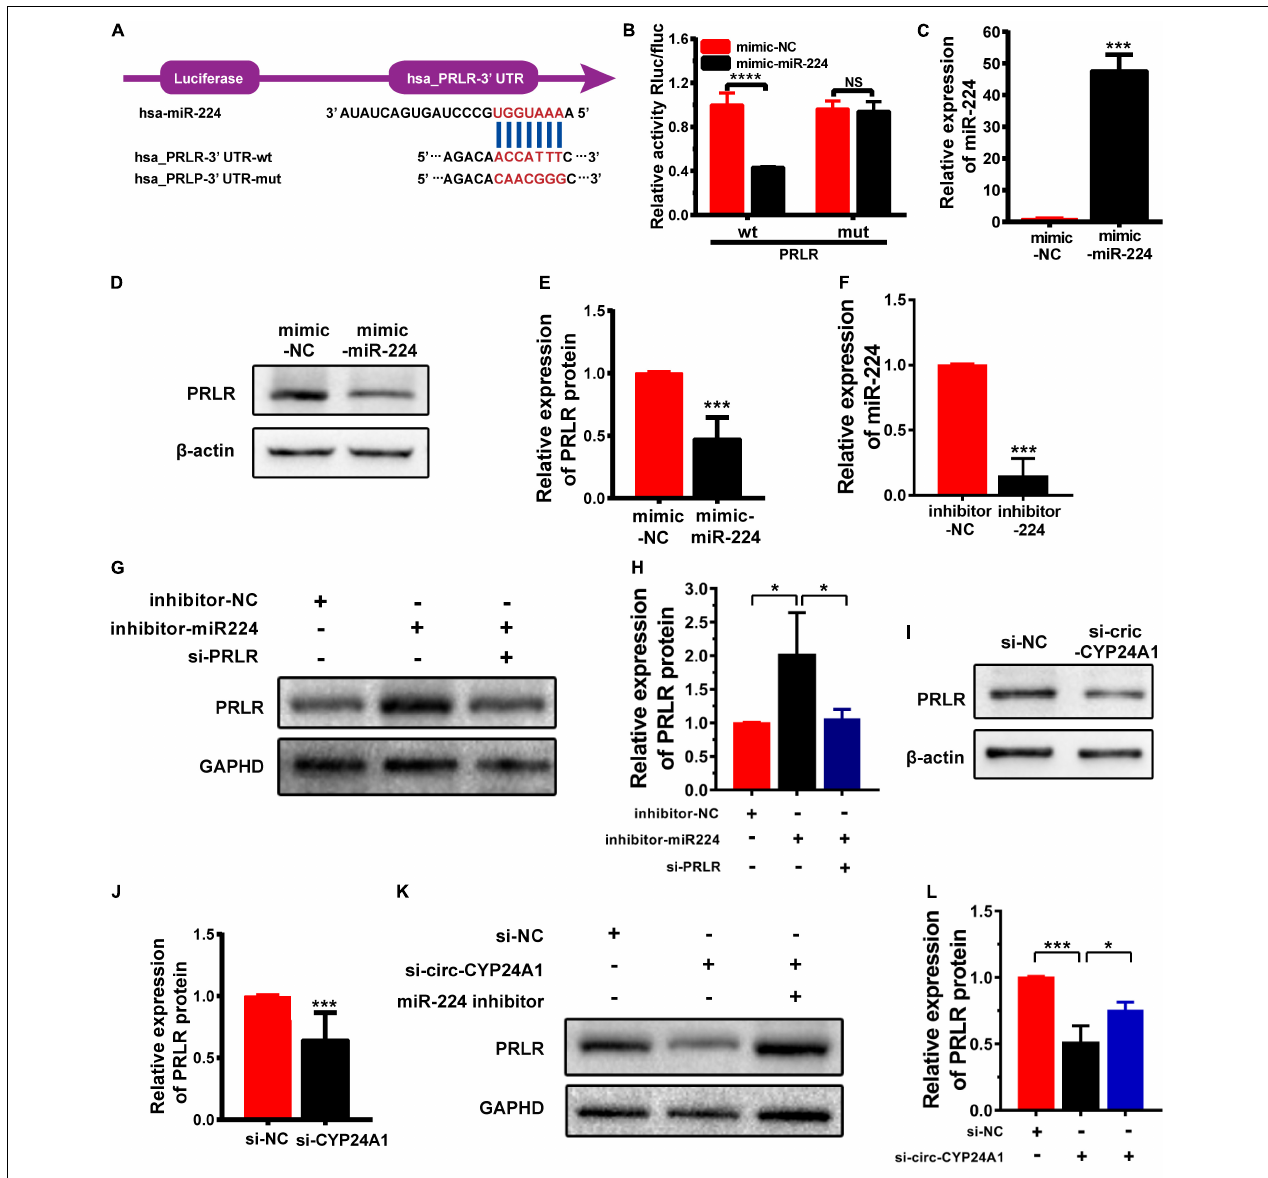
FIGURE 2 | PRLR is a downstream target of the circ-CYP24A1-miR-224 axis. (A) Bioinformatics prediction of the binding site of miR-224 to PRLR mRNA 3 (cid:48) UTR and the wild and mutant sequences of PRLR mRNA 3 (cid:48) UTR luciferase plasmid. (B) Expression of luciferase activity. (C) miR-224 levels were detected using RT-PCR. (D) The expression of PRLR was detected in Ishikawa cells transfected with miR-224 mimic. (E) Quantitative analysis of D. (F) miR-224 levels were detected using RT-PCR. (G) The expression of PRLR was detected in Ishikawa cells either transfected with miR-224 inhibitor or co-transfected with miR-224 inhibitor and PRLR siRNA. (H) Quantitative analysis of G. (I) The expression of PRLR was detected in Ishikawa cells transfected with circ-CYP24A1 siRNA. (J) Quantitative analysis of I. (K,L) The expression of PRLR was detected in Ishikawa cells transfected with circ-CYP24A1 siRNA or co-transfected with circ-CYP24A1 siRNA and miR-224 inhibitor. si-NC, negative control to siRNA; mimic-NC, negative control to biological mimic; inhibitor-NC, negative control to miR-224 inhibitor (* p < 0.05, *** p < 0.005, **** p < 0.001). cells. TUNEL-positive cells were observed in the inhibitor-NC, ( Figures 4D,E ). Apoptosis of Ishikawa cells was decreased in the miR-224 inhibitor group compared with the control